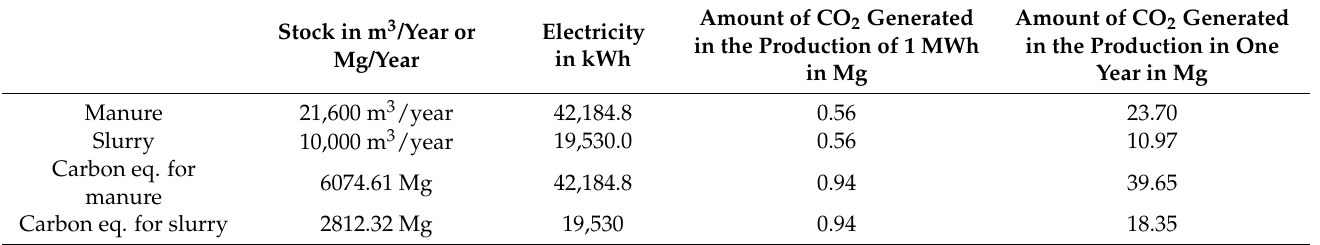
Table 2. Estimated CO 2 emission comparison for different fuels and their carbon